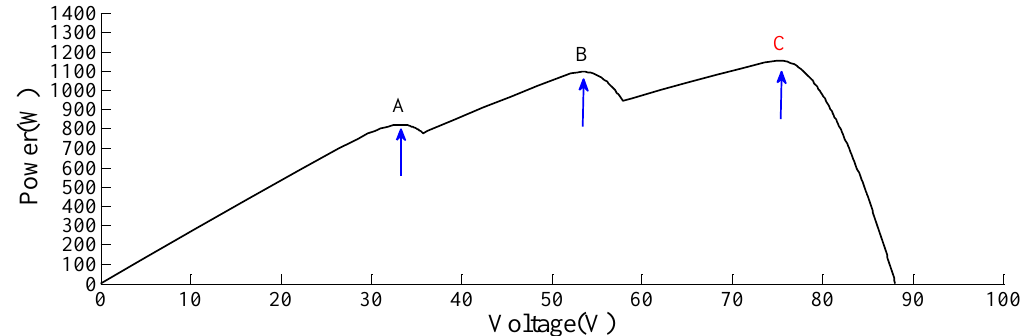
Figure 6. P-V curve of PV array under the second shade condition.